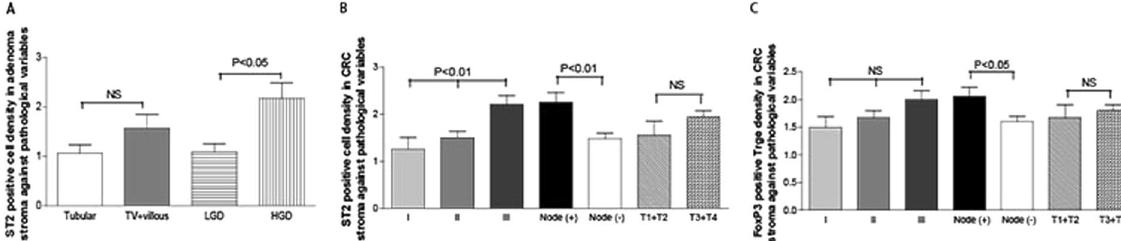
Figure 4. Clinicopathological analysis of ST2-positive cells and FoxP3-positive Tregs in patients with adenomas and CRCs. Further clinicopathological analysis revealed that increased densities of ST2-positive cells in the adenoma stroma ( A ) correlated with the degree of dysplasia, patients with high grade of dysplasia (HGD) tend to have a higher density of ST2-positive stromal cells than those with low grade of dysplasia (LGD). The density of ST2-positive cells in the CRC stroma correlates with TNM stages and node involvement ( B ), and the density of FoxP3-positive Tregs in the CRC stroma correlated with node involvement ( C ). NS: no significant, P > 0.05.